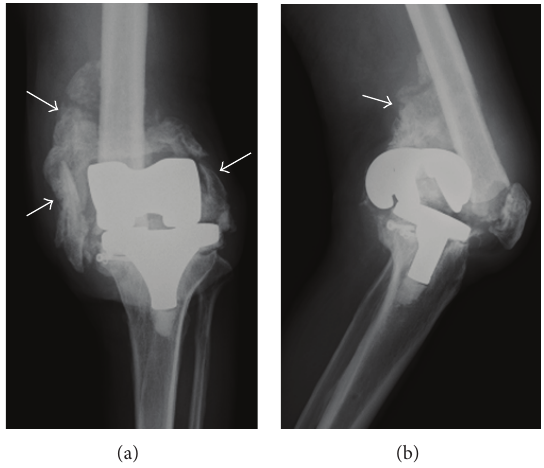
Figure 3: Radiographs of the left knee three months after the patient became unable to walk. Intra-articular bony fragments are enlarged and form giant ectopic ossified masses ((a), (b), arrows). Note that the femoral component is displaced and shifted posteriorly